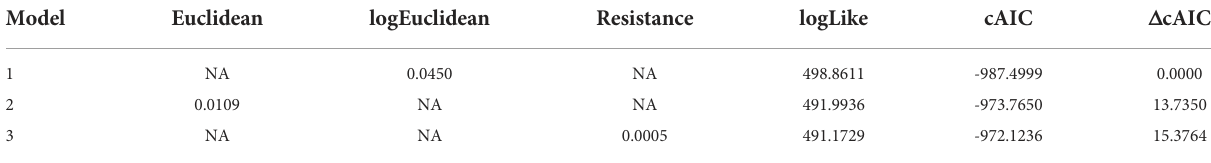
TABLE 6 Summary of maximum likelihood population effect (MLPE) analysis. Model